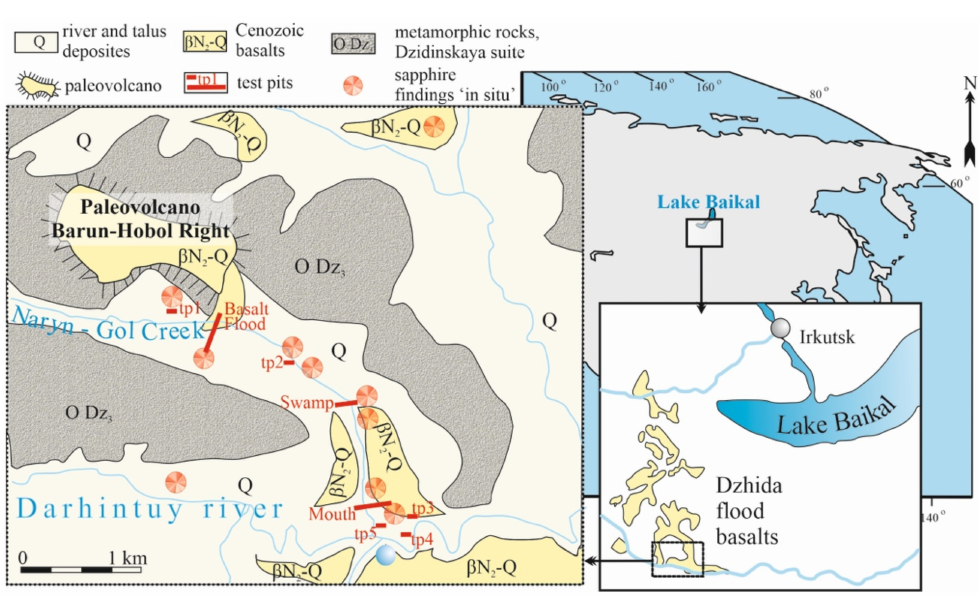
Figure 1. Geological setting of the Naryn-Gol Creek